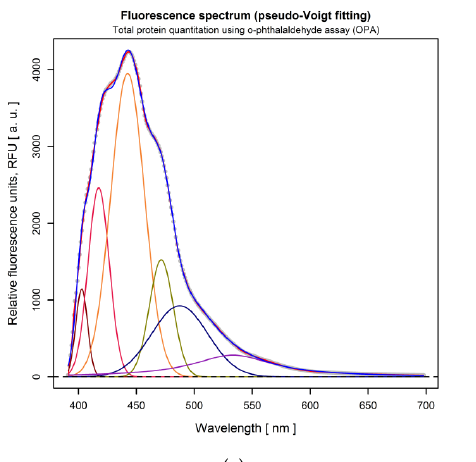
( c ) Figure 12. S eparation of chitin fractions from the deproteinization liquid extract: ( a ) LC extract; ( b ) insolubilized pellets after dialysis in D 2 O and ( c ) purified chitin fractions for analysis.